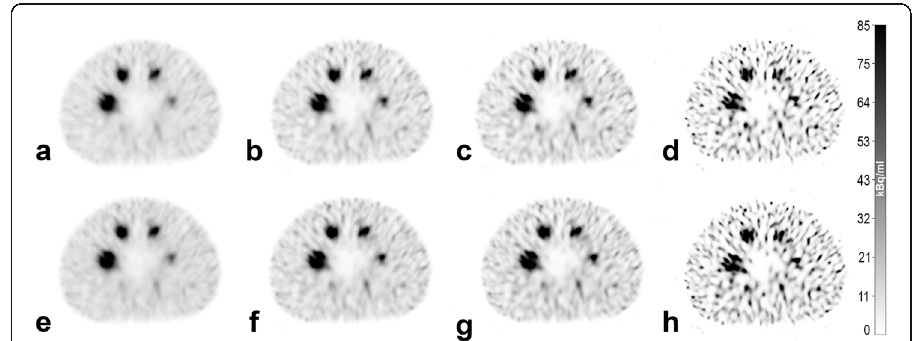
Fig. 4 SPECT images reconstructed from data acquired with the NEMA acquisition protocol. Reconstruction was performed with 2i/10s ( a and e ), 4i/10s ( b and f ), 5i/15s ( c and g ) and 24i/10s ( d and h ). Scatter correction was performed with ( a – d ) SCF = 1.10 and ( e – h ) SCF = 0.41. a and e Reconstructed with postfiltering typically used in diagnostic imaging. All SPECT images have an identical window level and width